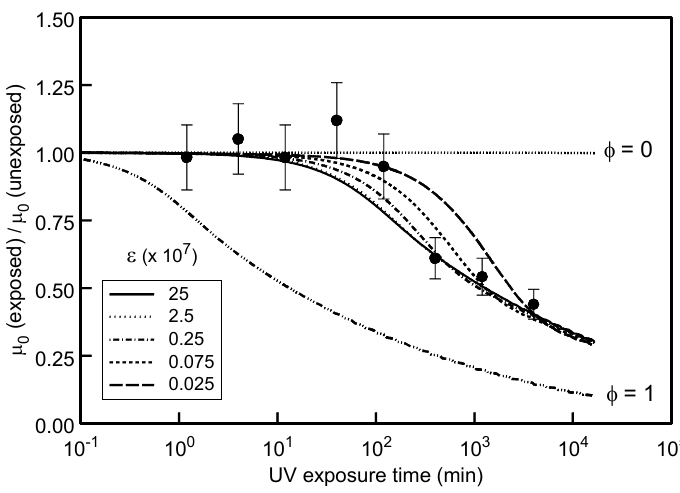
Figure 5. Variation of experimentally measured μ 0 with UV exposure period. The solid curves show the expected dependence based upon the modeled DEH photo-oxidation dynamics for the ε values given. φ = 0.01 in all cases except for those labeled.